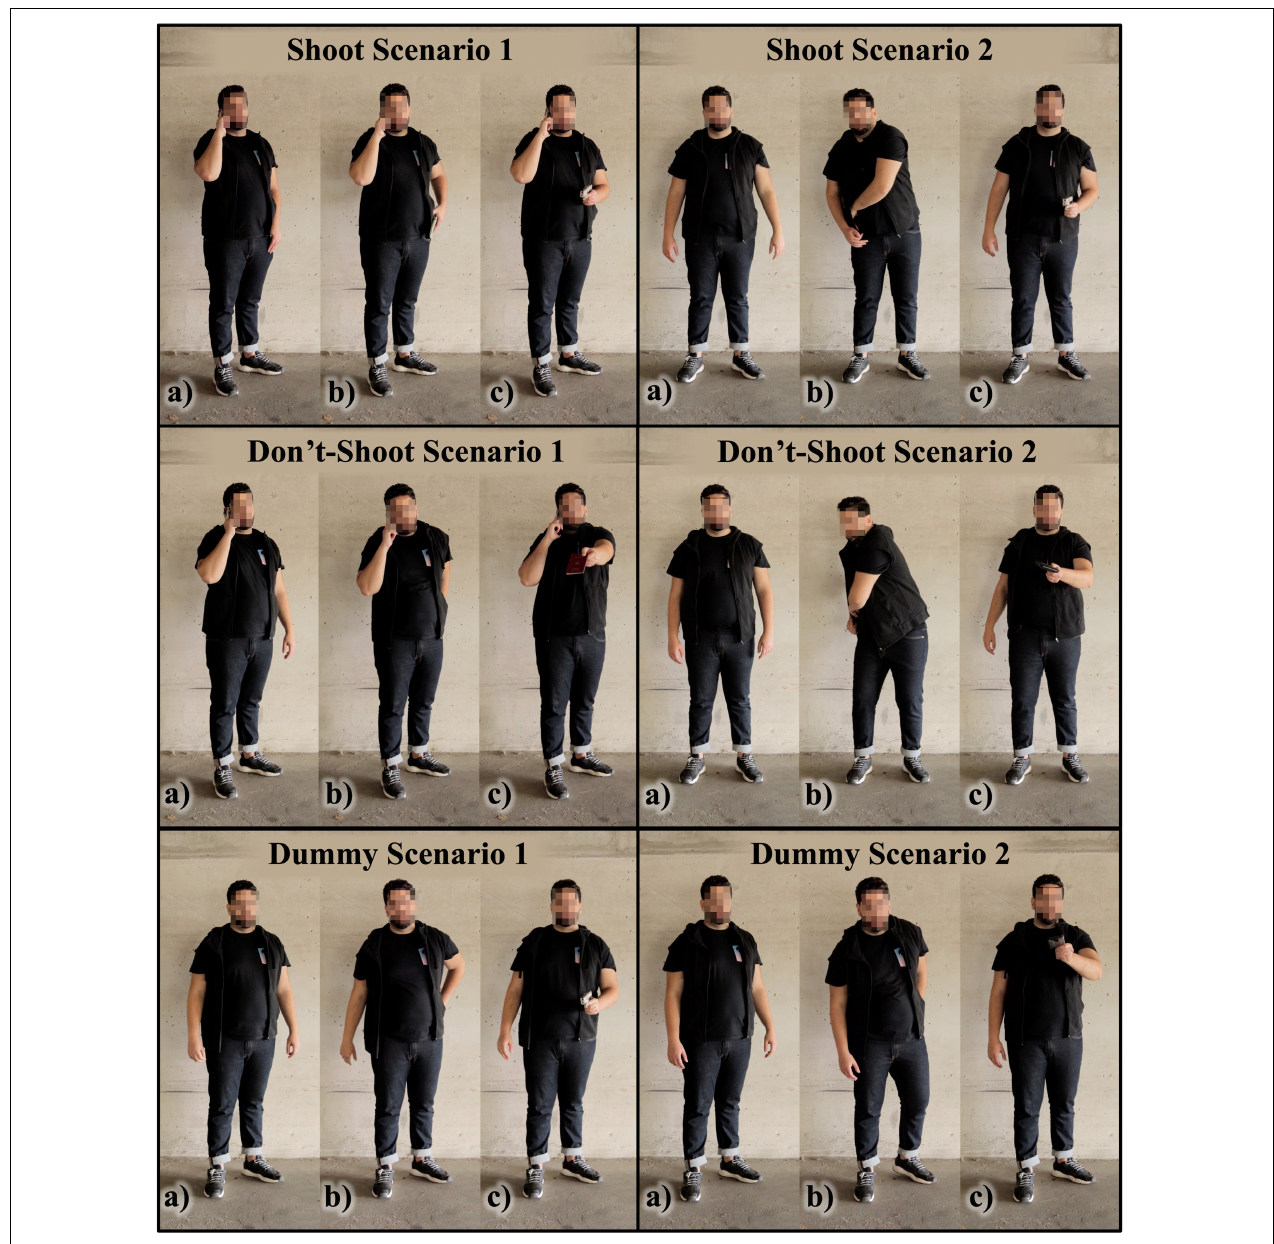
FIGURE 3 | The six different scenarios of task 2. (a) The initial situation, (b) the drawing motion, (c) the suspect’s final position with the drawn